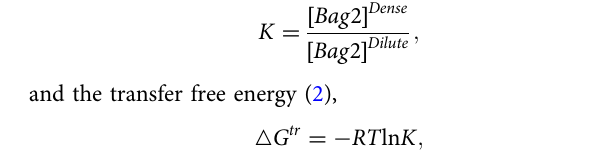
Fig. 3 Mutational analysis of BAG2 condensate function. a Model of a multi-oligomerization structure of BAG2-full length protein representing the N and C termini interactions. b Mutation sites used to study BAG2 condensation in c – f . c Representative images (top) and plot (bottom) showing SH-SY5Y cells transfected with clover-BAG2 full length, clover-BAG2- Δ 20-61 and clover-BAG2-I160A before and after stress (Sucrose 125 mM, 15 min). Plots: the percentage of clover-BAG2 cells that contained condensates before and after stress (* p = 1.9 × 10 − 7 , two-sided Student ’ s t test). d Same experiment performed in c using clover-BAG2-S20E (phosphomimetic) and clover-BAG2-S20A (non-phosphorylatable) before and after stress (Sucrose 125